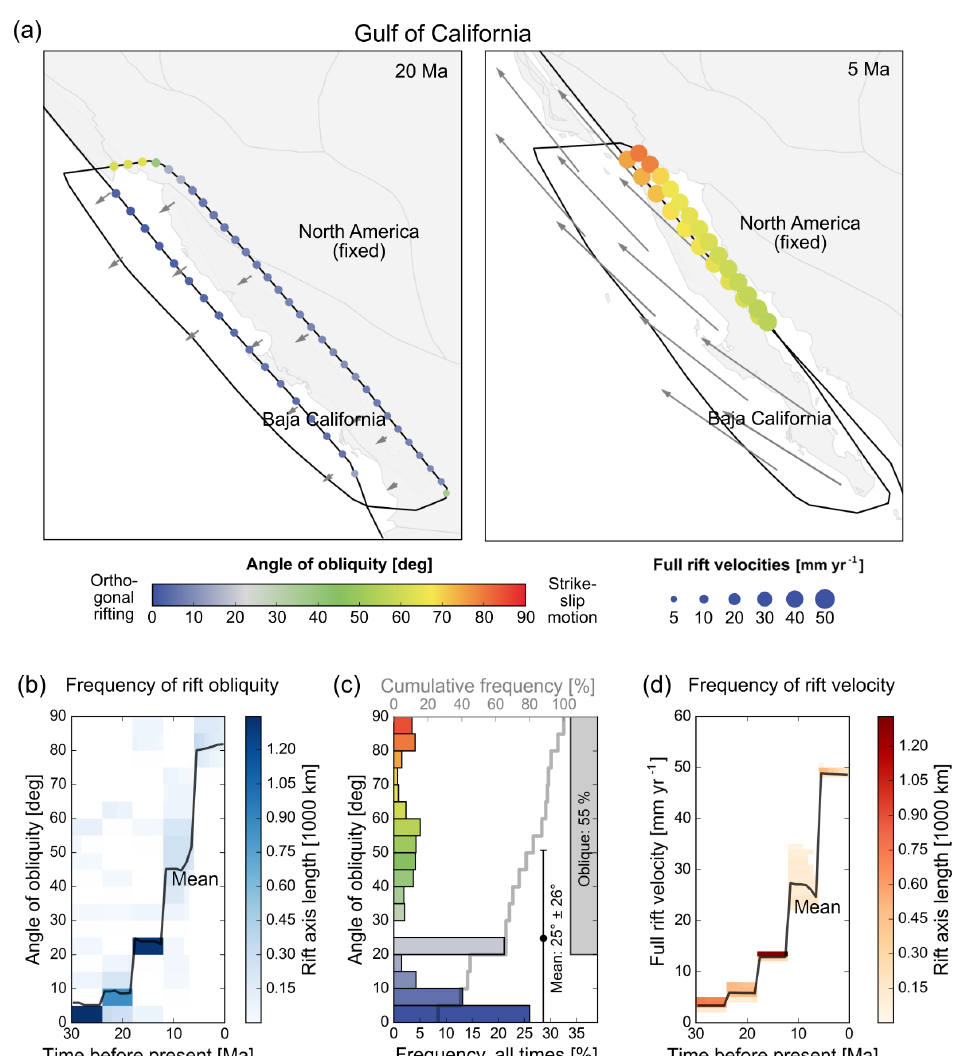
Figure 7. Gulf of California rift. The initial rift phase is characterized by slow, predominantly orthogonal extension and associated with a wide rift. An increase in rift obliquity enhances localization between 20 and 10Ma inducing continental breakup. The obliquity and velocity of this rift increases almost proportionally. For explanation of symbols and diagrams see caption of Fig.